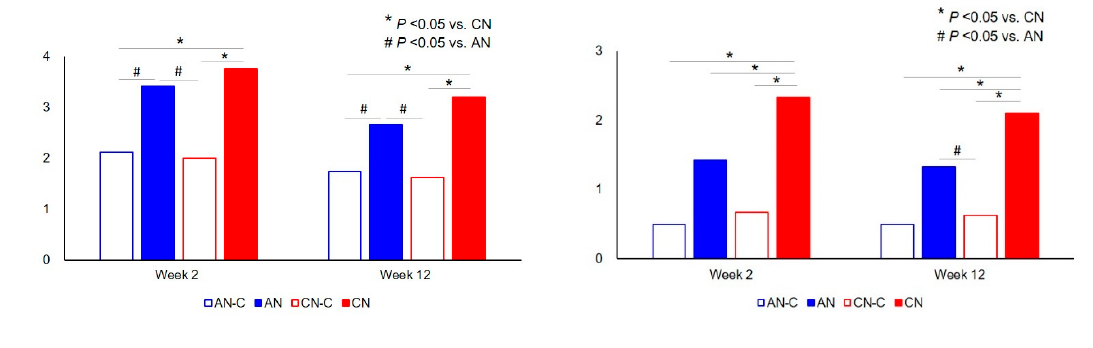
Figure 4. The glomerular matrix and interstitial fibrosis (IF) scores among the four groups at both the 2W and 12W time points. ( a ) glomerular matrix score, ( b ) interstitial fibrosis score. There were significant differences in both the glomerular matrix and IF scores among the four groups at both the 2W and 12W time points. AN, acute nephritis; AN-C, control group for acute nephritis; CN, chronic nephritis; CN-C, control group for chronic nephritis. * p < 0.05 vs. CN, # p < 0.05 vs. AN.